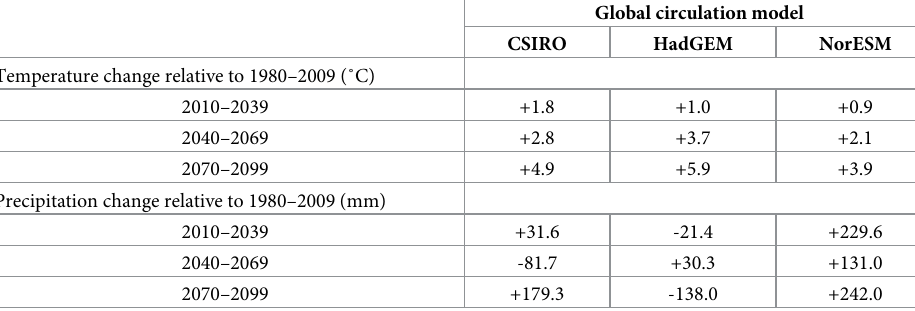
Table 1. Changes in modal temperature and precipitation values projected by three global circulation models (GCMs) for the study